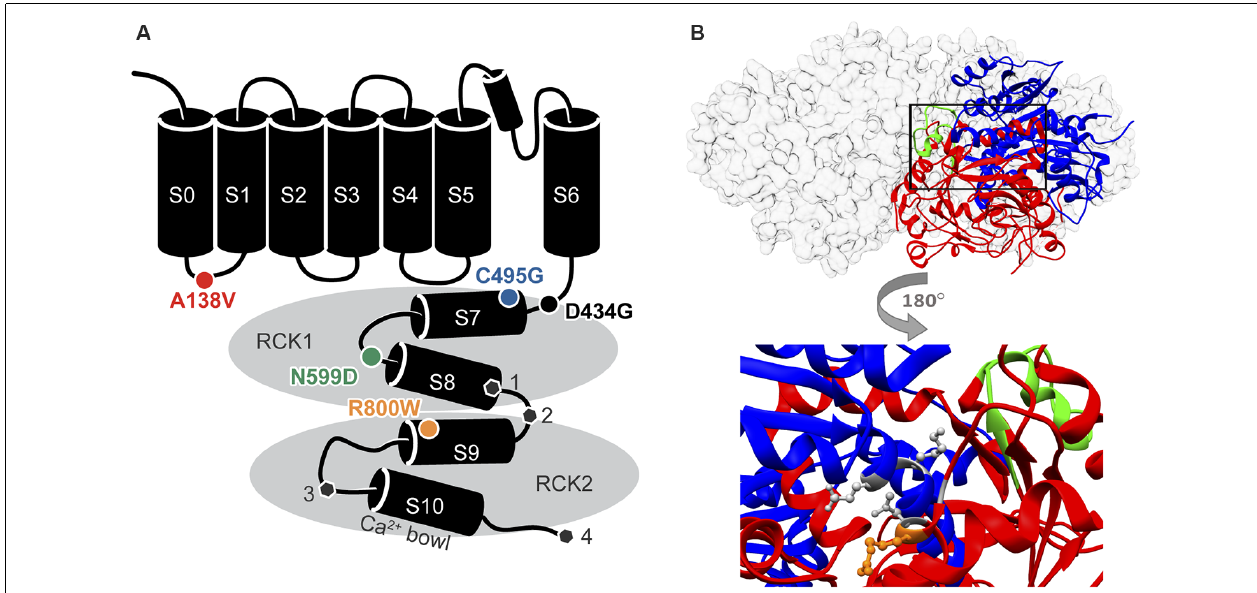
FIGURE 1 | Locations of single nucleotide polymorphism (SNP) residues in the BK channel α subunit. (A) SNPs located in the in the S0-S1 linker (A138V) and the intracellular “gating ring” domain (C495G, N599D, and R800W) were introduced into two human BK channel splice variants. The sites of alternative splicing ( ,